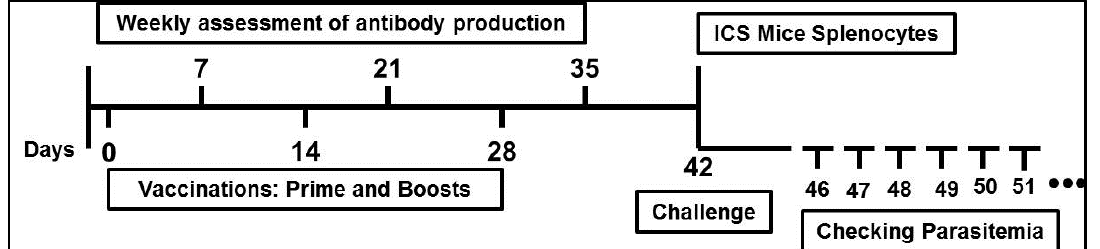
Figure 1. Experimental design using Plasmodium vivax thrombospondin-related adhesive protein (PvTRAP) protein as antigen: the schedule was designed to assess the kinetics of antibody production; T cell responses and protection against Plasmodium berghei expressing PvTRAP. BALB/c mice were vaccinated intramuscularly three times: prime (Day 0), first boost (Day 14) and second boost (Day 28). Serum was taken weekly until one week before the challenge. On Day 42, 5 mice per group were culled to collect the spleens for intracellular cytokine staining (ICS), and another 6 were challenged with P. berghei exhibiting PvTRAP replacement. Parasitaemia was checked daily, from the fourth day after challenge until the mice reached 1% parasitaemia.